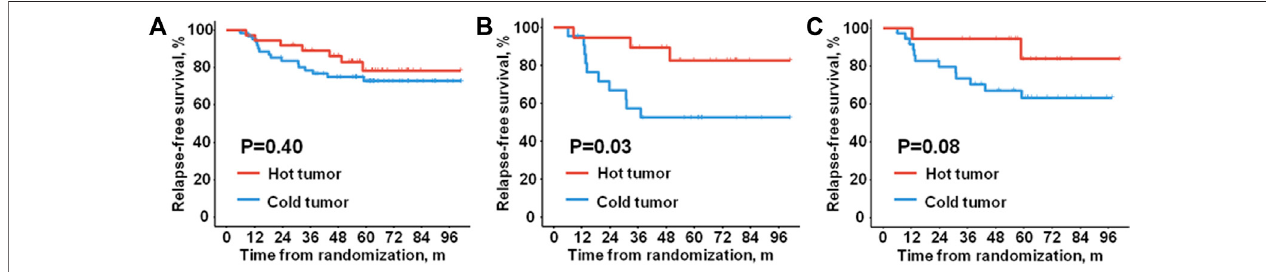
FIGURE 2 | Relapse-free survival of different microenvironment phenotypes. Kaplan-Meier plots show relapse-free survival of (A) all the enrolled patients, (B) the node-positive patients, and (C) the patients with tumors in stage pT2-3.